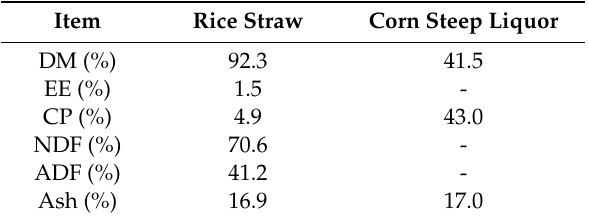
Table 1. Contents of chemical components of raw materials (DM basis).